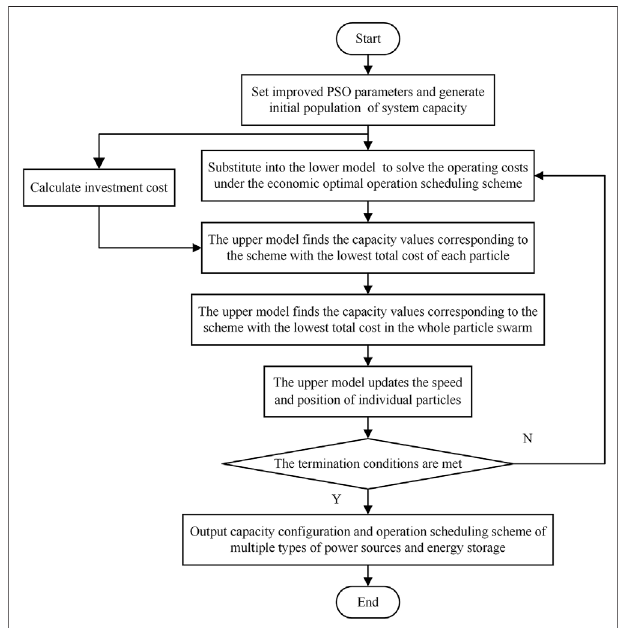
FIGURE 3 | Flowchart of the robust bi-level planning method for the multi-source system.